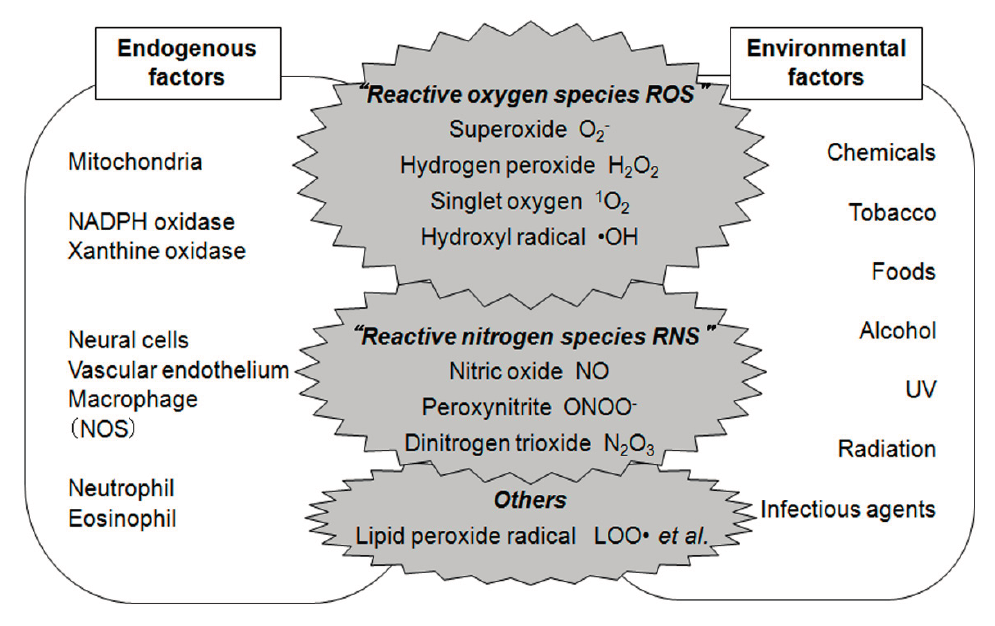
Figure 1. Reactive oxygen species and reactive nitrogen species (ROS and RNS) and their sources from endogenous and environmental